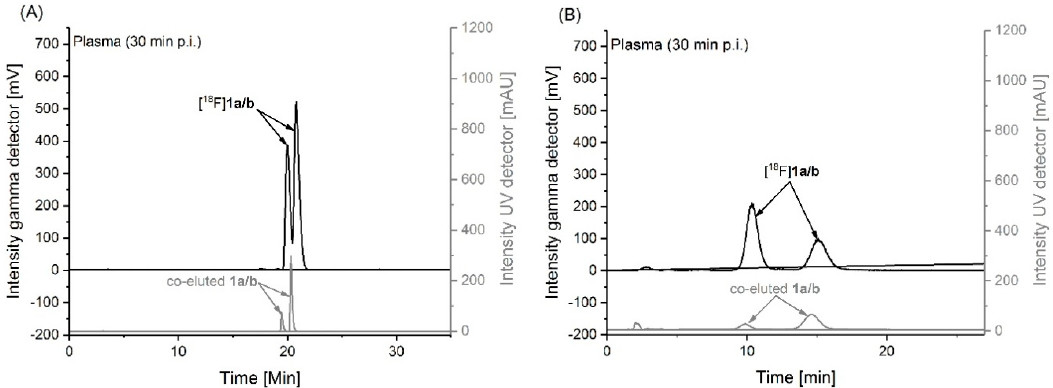
Figure 5. Analytical UV- and radio-HPLC chromatograms representing two peaks a / b which are supposed to reflect the neutral and deprotonated form of the radiotracer ([ 18 F] 1a / b ) in mouse plasma at 30 min p.i. measured under: ( A ) reversed phase (Reprosil-Pur C18-AQ, 250 × 4.6 mm, gradient with an eluent mixture of ACN / 20 mM NH 4 OAc (aq.), 370 nm, 1.0 mL / min), and ( B ) micellar conditions (Reprosil-Pur C18-AQ, 250 × 4.6 mm, isocratic mode with water containing 50 mM sodium dodecyl sulfate / 10 mM NaHPO 4 , 1.0 mL /